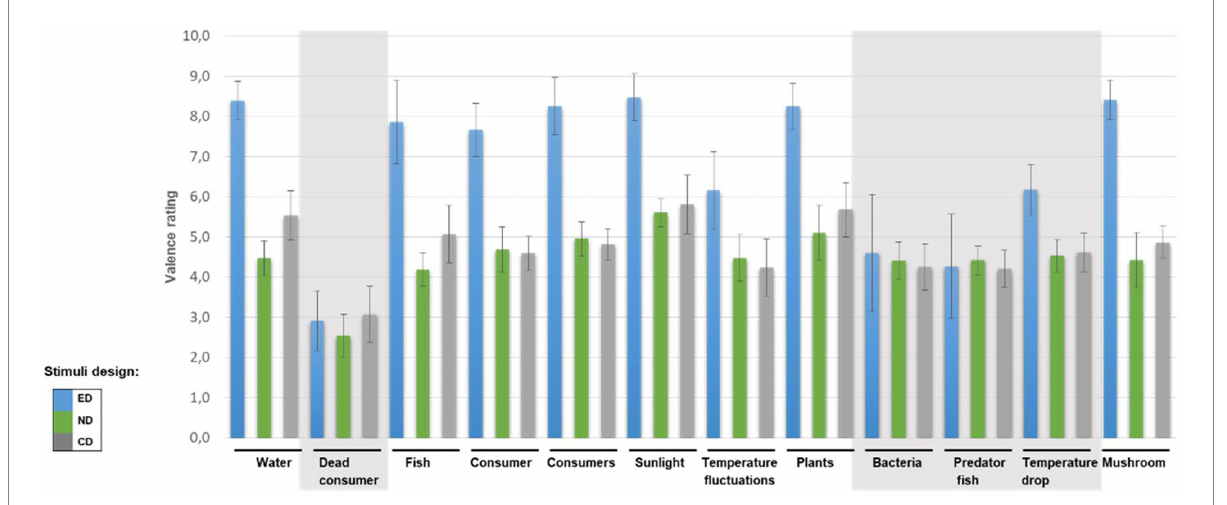
FIGURE 2 Mean valence rating and standard deviations for different concepts in emotional design (ED), neutral design (ND), and control design (CD). The higher the valence ratings, the more pleasant the concept is perceived. Concepts that differ significantly in valence ratings from the other concepts are highlighted in grey. Highlighting is based on post-hoc analyses which can be viewed in the Supplementary material